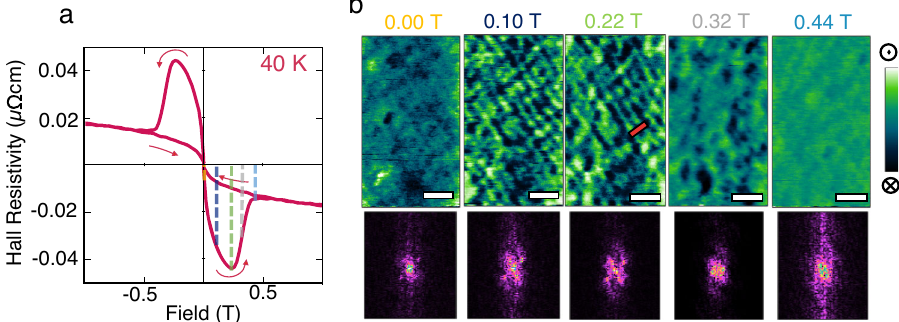
Fig. 2 MFM experimental data correlated with Resistive Hall data. a Resistive Hall curve acquired at 40 K. b Sequential MFM images acquired at 0.00, 0.10, 0.22, 0.32, and 0.44 T. Each scan is colour coded with dashed lines in a to correlate with the Hall measurements. Scale bars are 500 nm, colour bars are − 0.3° to 0.3°. Below each image is a fast Fourier transform (FFT) of the respective image. All MFM images and their corresponding FFT are available in the Supplementary Information as well as in Supplementary Movie 1. Red bar at 0.22 T indicates location of line scan used in Fig. 3f.